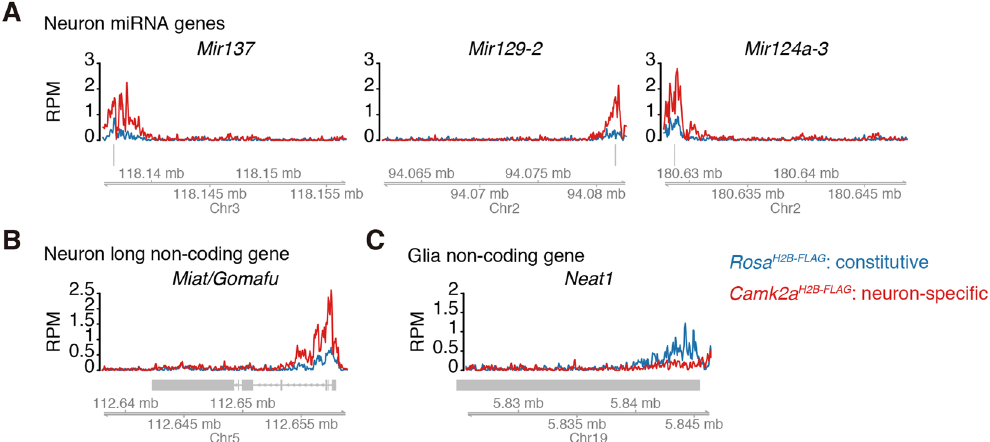
Figure 5. Neuron-specific ncRNAs verified by tChIP-Seq. ( A – C ) Distribution of reads from tChIP-Seq of Rosa H2B-FLAG and Camk2a H2B-FLAG mice along neuron-specific miRNA loci ( A ), long non-coding RNA loci ( B ), and glia-specific long non-coding RNA loci ( C ). RPM: reads per